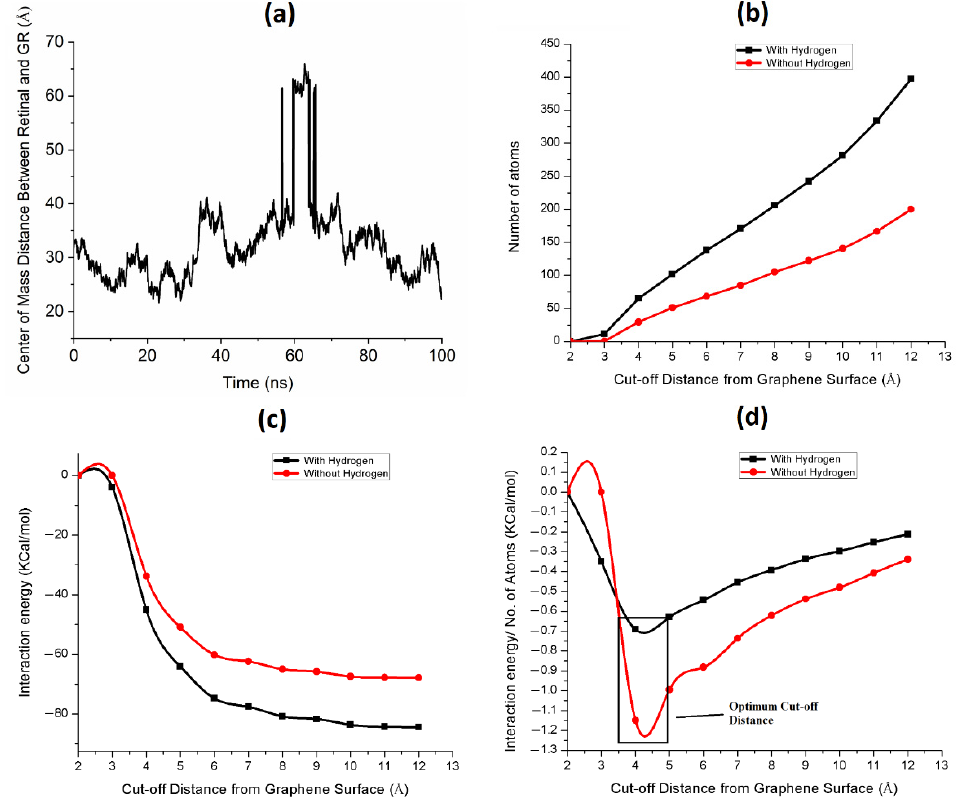
Figure 7. Optimal distance analysis between bR and graphene: ( a ) Distance between the center of the masses of graphene and retinal; ( b ) Number of atoms of bR with respect to cut-off distance; ( c ) Total interaction energy between bR and graphene with respect to cut-off distance; ( d ) Optimal distance between bR and graphene where minimum number of atoms drive the interactions at the interface. Note: in all plots, the data were gathered with and without hydrogen atoms to see the effect of heavy atoms (O, C and N) on the interface.